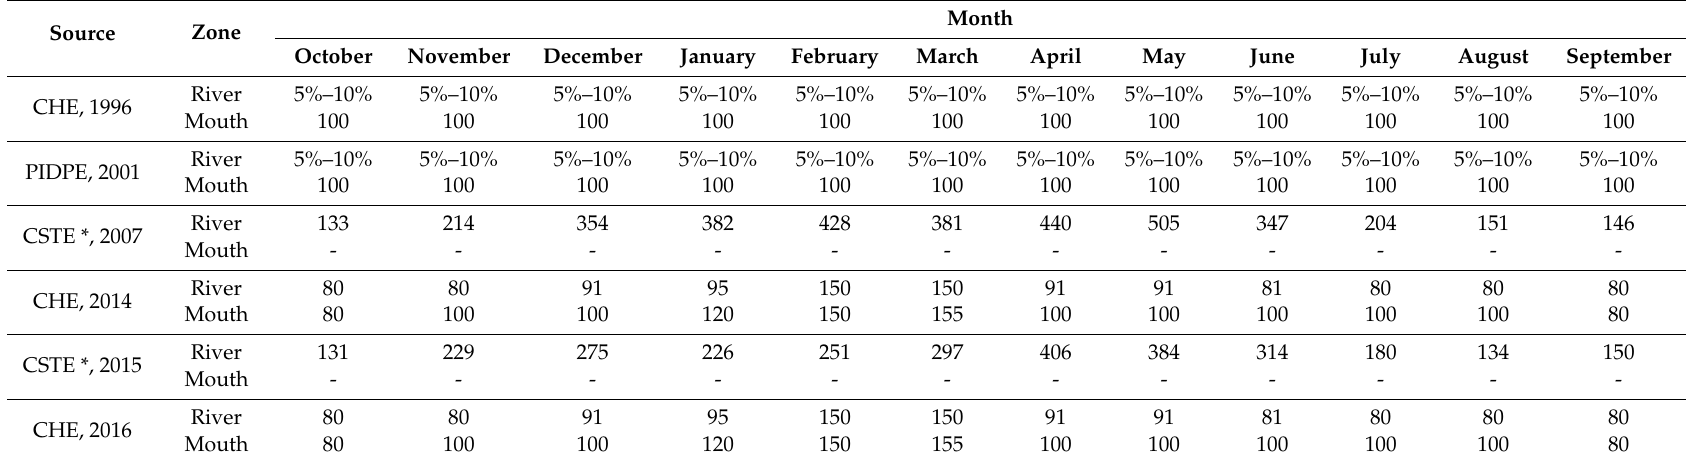
Table 1. Environmental flow regimes (in m 3 / s, except when flows are expressed as percentage of the natural mean interannual runo ff ) proposed and implemented for the lower Ebro River (and its delta) in the last 20 years (CHE (in Spanish): Ebro’s Hydrographic Confederation; PIDPE (in Spanish): Integral Protection Plan of the Ebro Delta; CSTE (in Catalan): Commission for the Sustainability of the Ebro’s